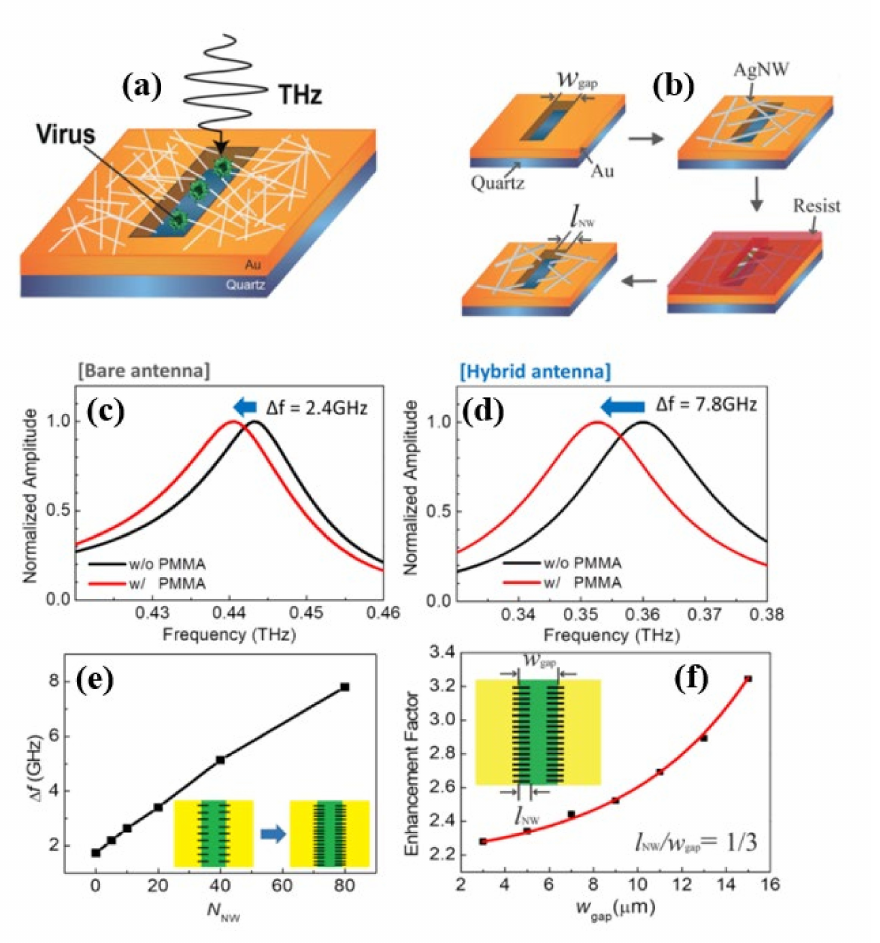
Figure 11. ( a ) Schematic of the THz hybrid slot antenna with protruding AgNWs. ( b ) fabrication processes for the THz hybrid slot antenna, ( c ) FDTD simulation transmission spectra through the bare slot antenna with (red) and without (black) PMMA [L = 200 µ m and wgap = 15 µ m]. ( d ) Transmission spectra through the hybrid slot antenna with (red) and without (black) PMMA for lNW = 5 µ m. ( e ) Resonant-frequency shift as a function of the total number of AgNWs (NNW). ( f ) Enhancement factor as a function of wgap for fixed NNW = 80 and lNW/wgap = 1/3. Reprinted with permission from [67]. Copyright 2018